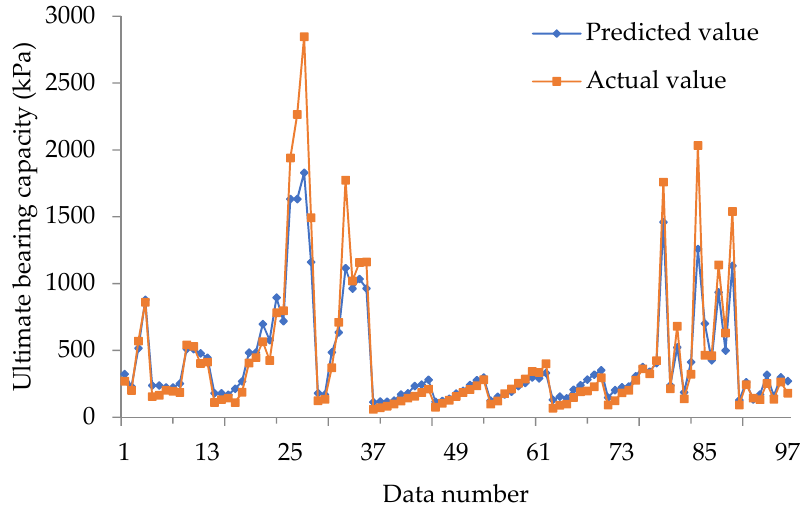
Figure 3. Actual versus predicted ultimate bearing capacity values.